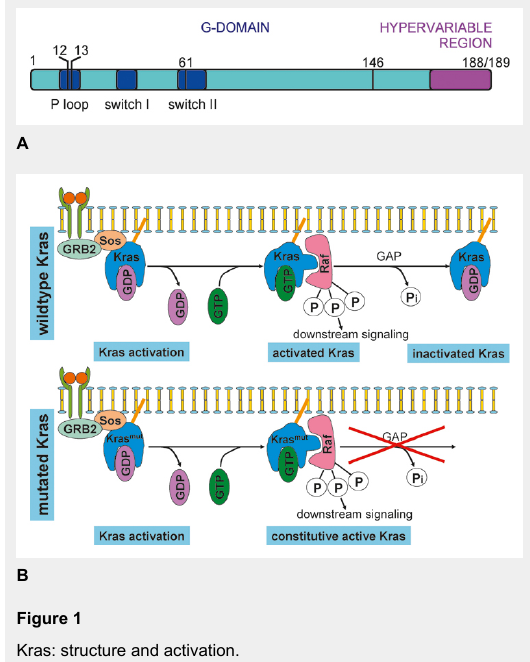
Kras: structure and activation. (A) The Kras gene. Mutations in human tumours occur most commonly in codons 12 or 13 but mutations in codons 61 and 146 have been described. (B) Kras activation. Following the activation of a receptor tyrosine kinase (RTK), a complex containing the activated receptor, GRB2 (growth factor receptor-bound protein 2) and Sos (son of seven- less) is formed on the cytosolic face of the cell membrane. Binding of Sos to Kras-GDP leads to a conformational change of the switch 1 and 2 regions, thereby mediating the exchange of GDP for GTP. This triggers a second conformational change that allows Ras-GTP to bind to and activate Raf. In wild-type Kras (top panel), signalling is terminated by hydrolysis of GTP to GDP. In mutated Kras (bottom panel), the GTPase activity of Kras is severely impaired, making hydrolysis of GTP and termination of signalling impossible. GEF = GTP exchange factor. GAP = GTPase activating